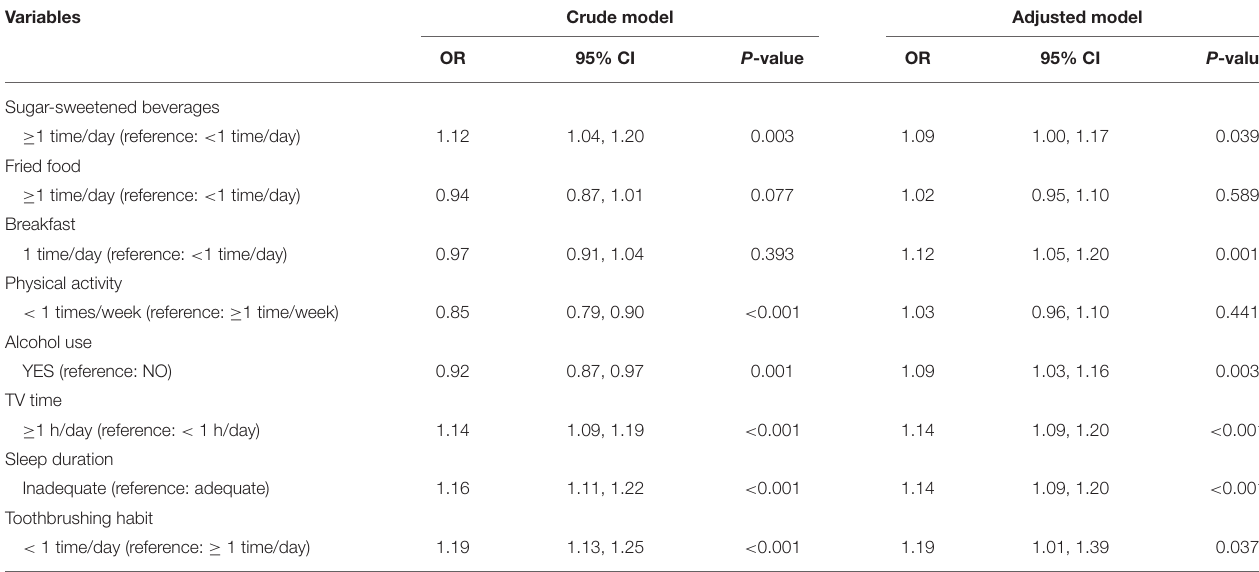
TABLE 2 | Associations between preventable lifestyle factors and overweight/obesity. Variables Crude